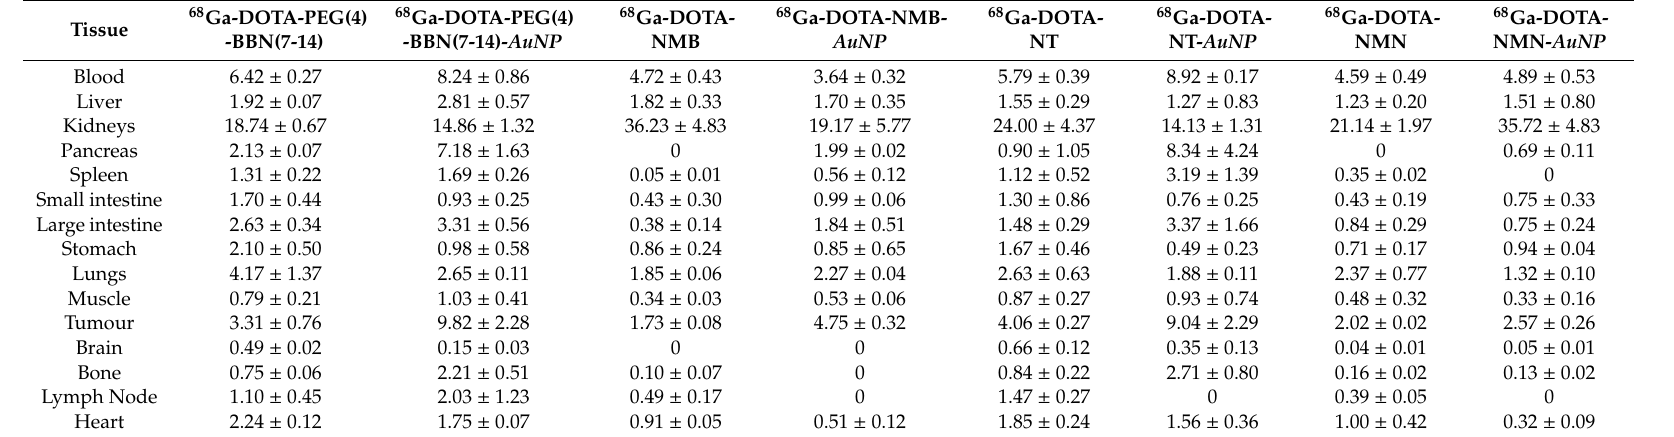
Table A1. Ex vivo biodistribution data on NU / J mice inoculated with HT-29 colon cancer cells.